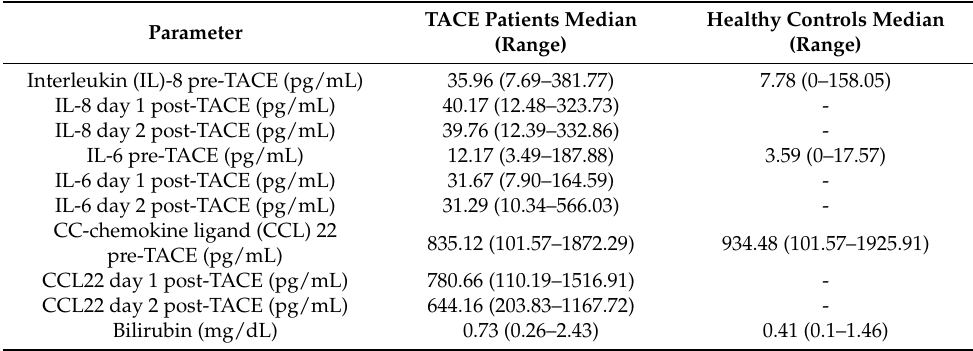
Table 1. Serum levels of laboratory